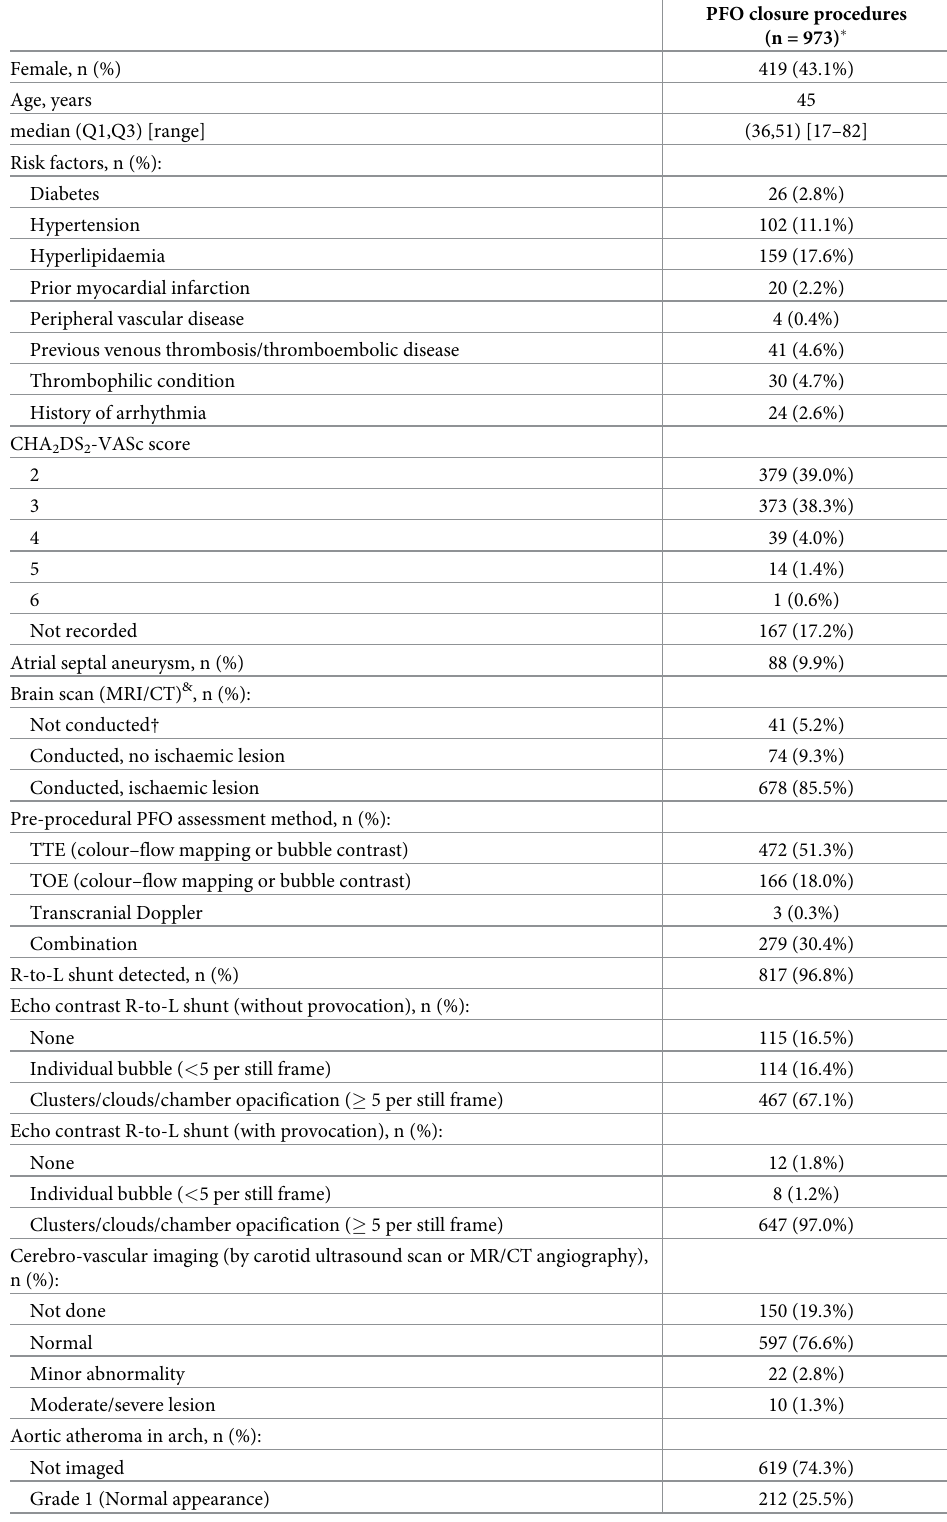
Table 1. Procedural characteristics and